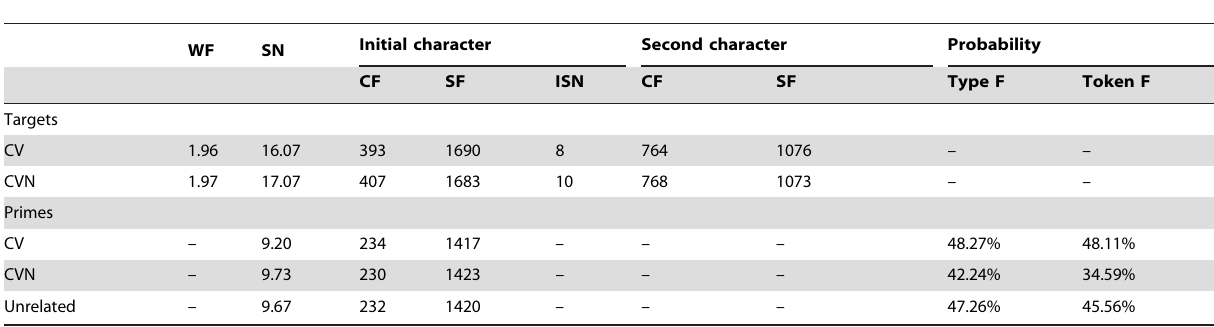
Table 5. Properties of the stimuli used in Experiment 4.